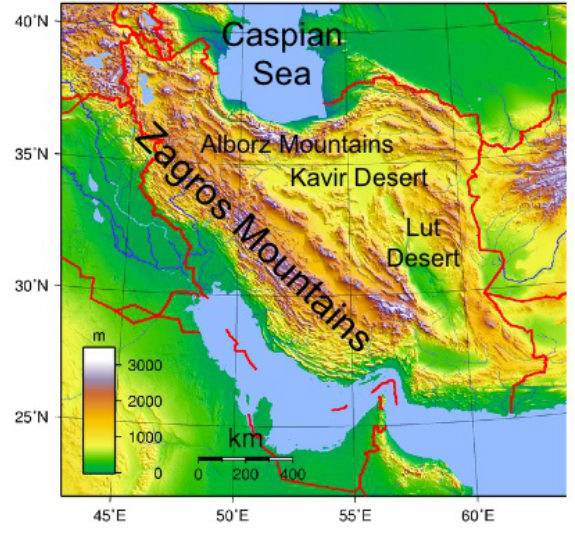
Fig. 1. Topographic map of Iran. Fig. 1 . Topographic map of Iran.